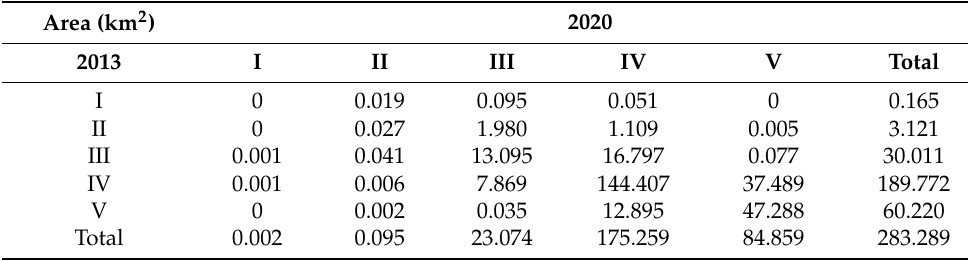
Table 3. RSEI and mean value of each index.